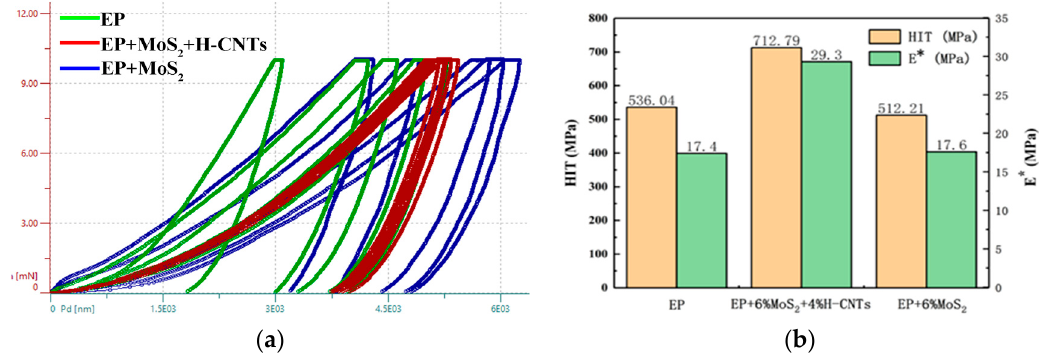
Figure 12. Nanoindentation test. ( a ) Loading and unloading curve. ( b ) Hardness and elastic